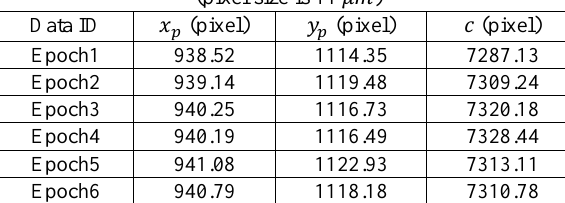
Table 3. Sample IOPs of camera model